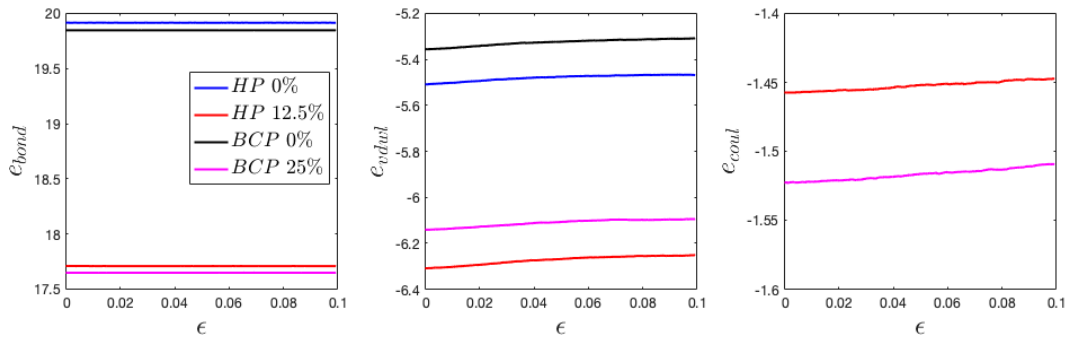
Figure 13. The change of bonded ( e bond ), Van der Waals ( e vdwl ), and coulombic energy ( e coul ) during tensile loading perpendicular to the interface.